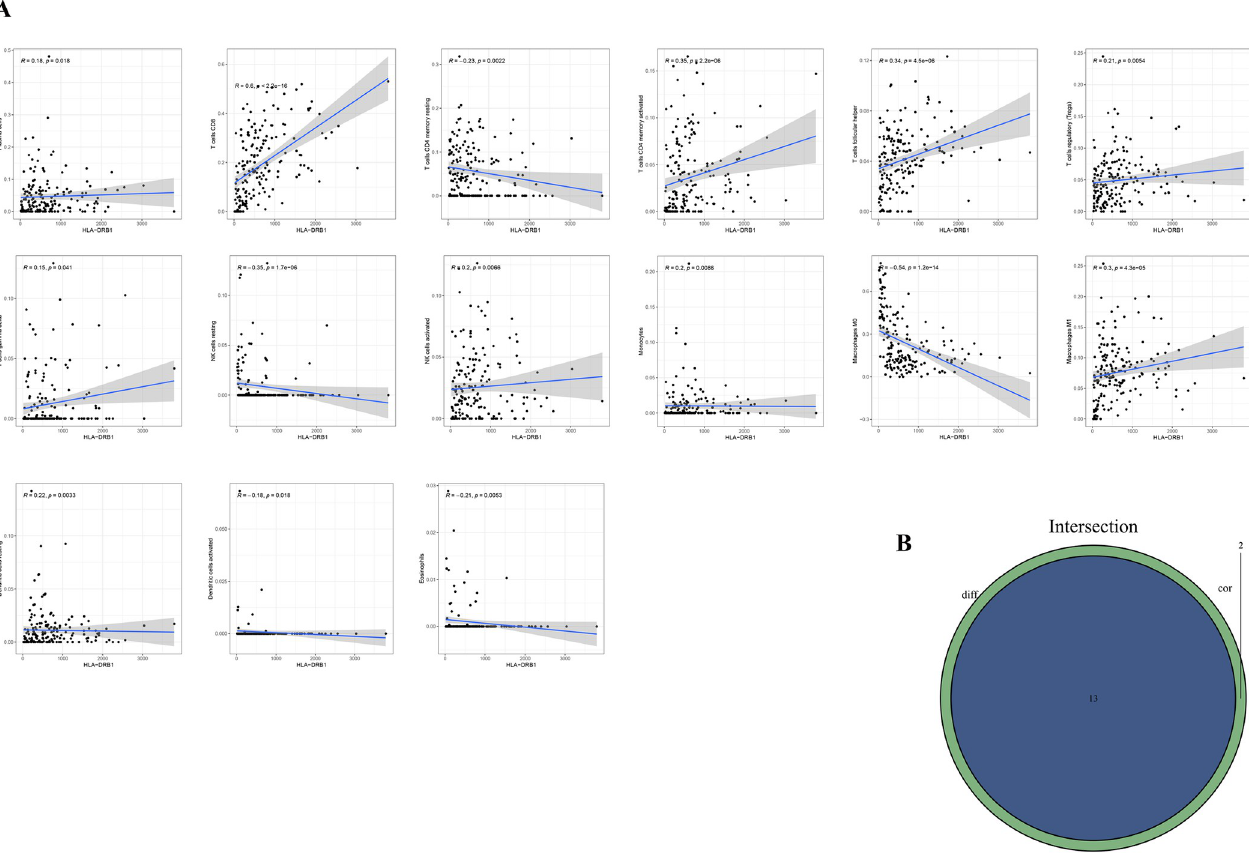
Fig 9. Correlation between TICs proportion and HLA-DRb1 expression. (A) The scatter plot described 15 types of TICs whose proportions were correlated with the expression of HLA-DRB1. (B) The Venn plot displayed the result of the intersection analysis.